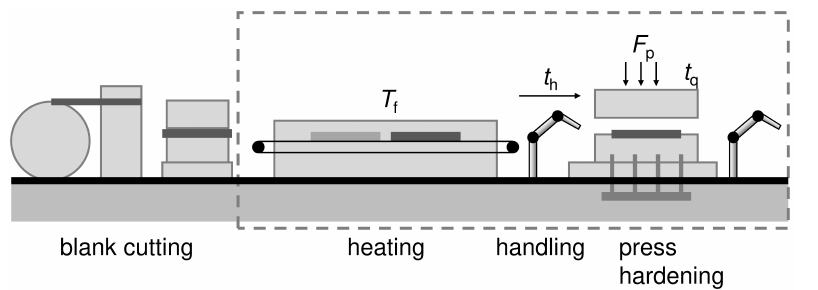
Figure 2. Side view of the press hardening process [47] indicating the considered process steps.